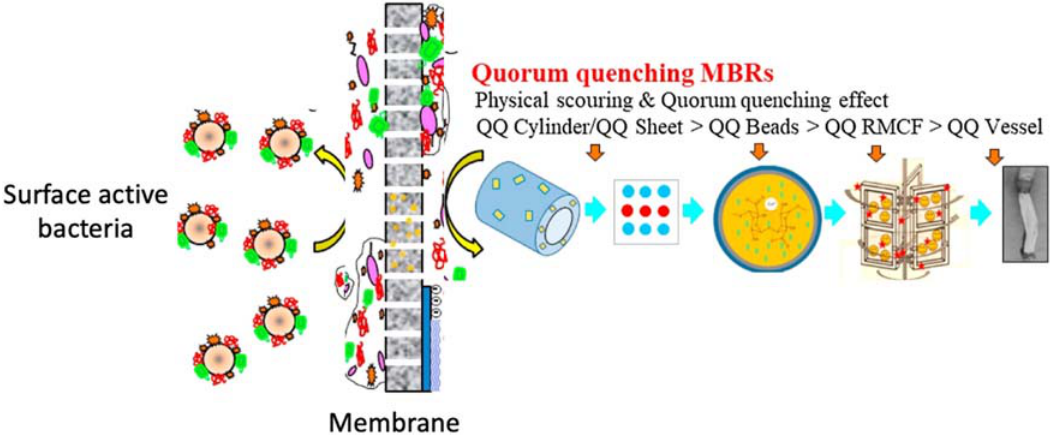
Figure 3: Advances in biofouling control [ 81 ]